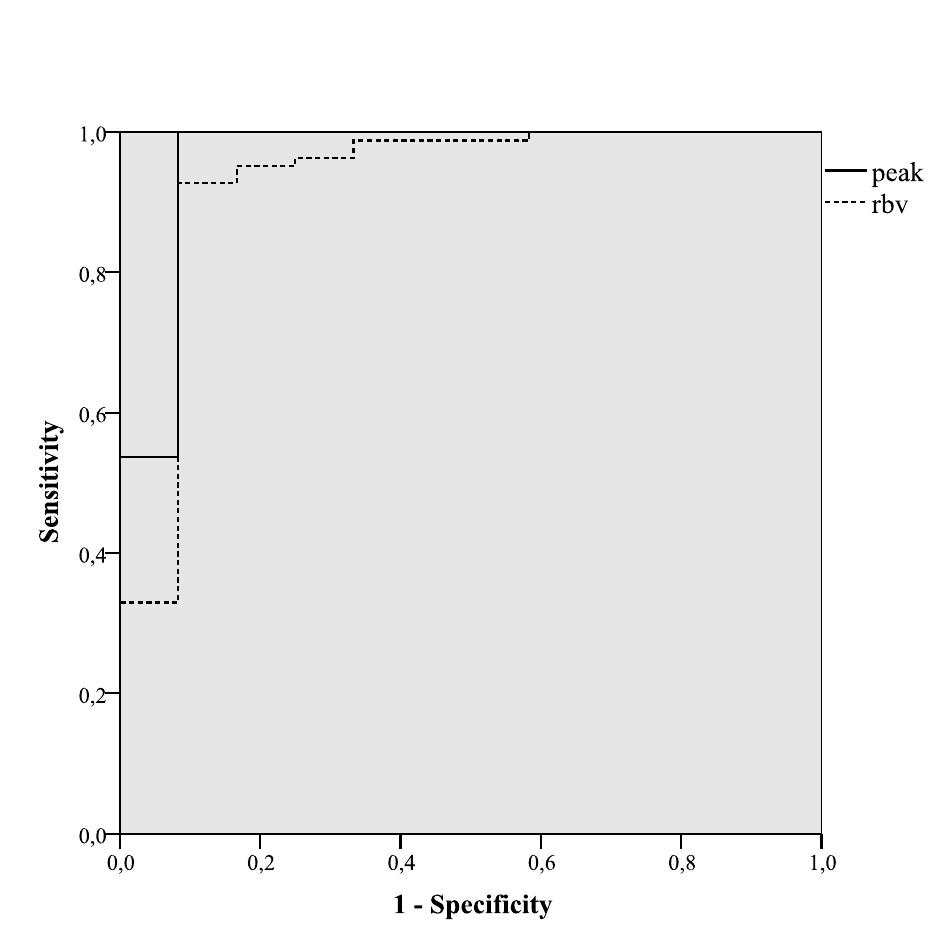
Fig 4. Receiver Operating Characteristic curve for performance of Contrast enhanced Ultrasound for the diagnosis of active ileitis at endoscopy. Peak intensity (solid line) and Regional Blood Volume (dotted line).